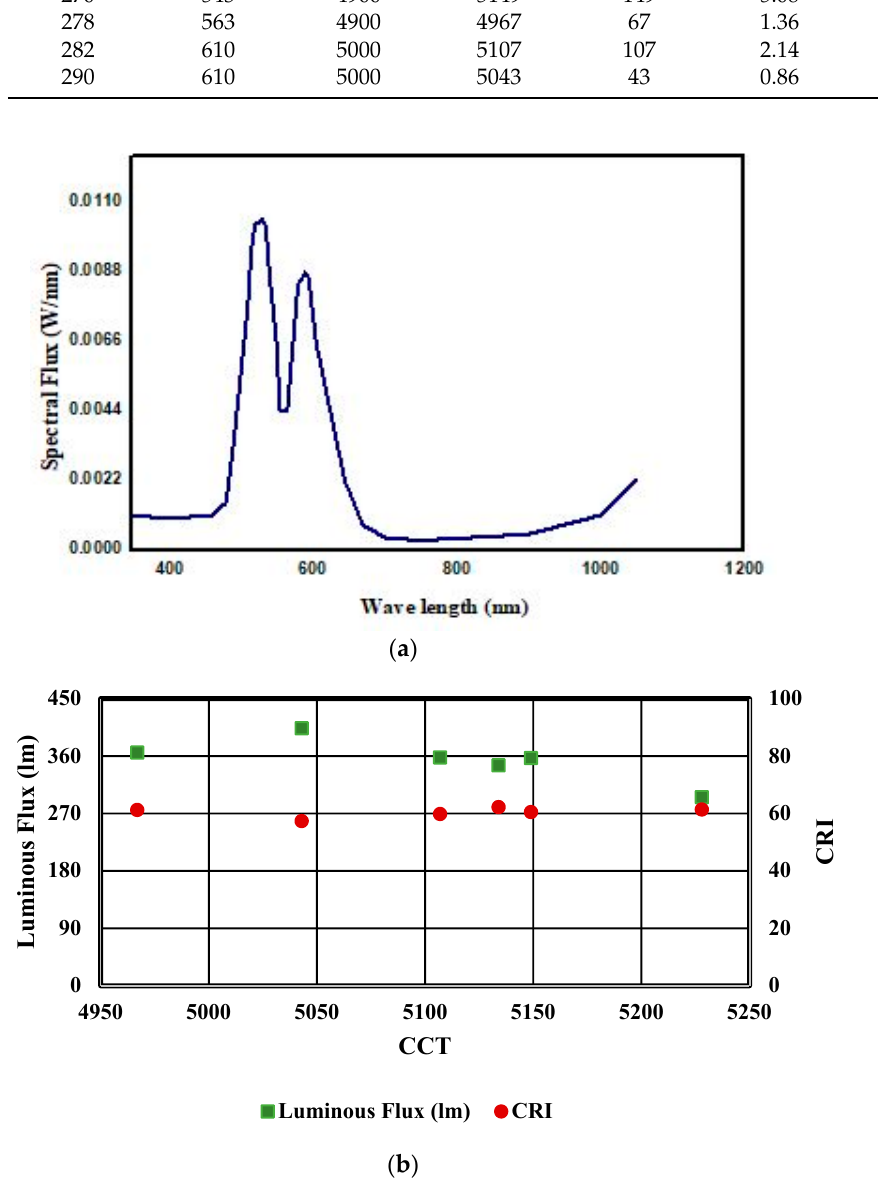
Figure 8. ( a ) Spectral distribution of composite R-G color measured using the Lab-sphere Photo metric Measurement System. ( b ) Luminous flux and CRI vs. CCT variation.